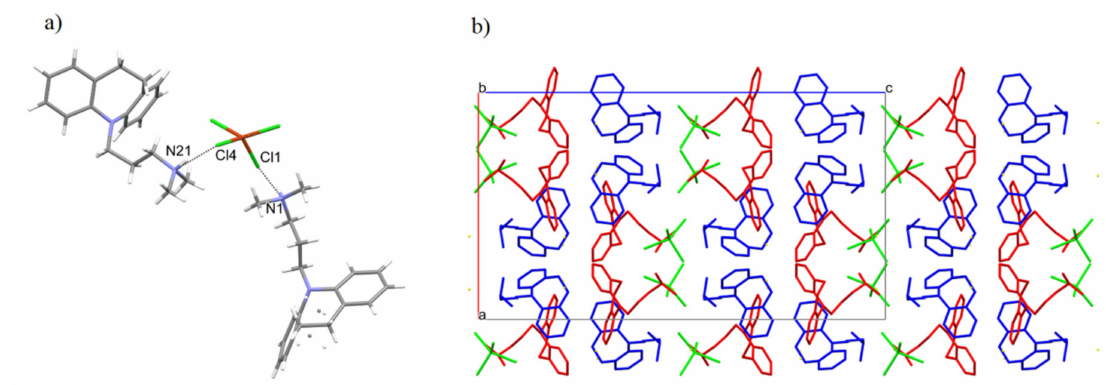
Figure 2. ( a ) The intermolecular hydrogen bonds. ( b ) Packing of the molecules in the crystal of [HL] 2+ [CuCl 4 ] 2 − compound along the b axis.